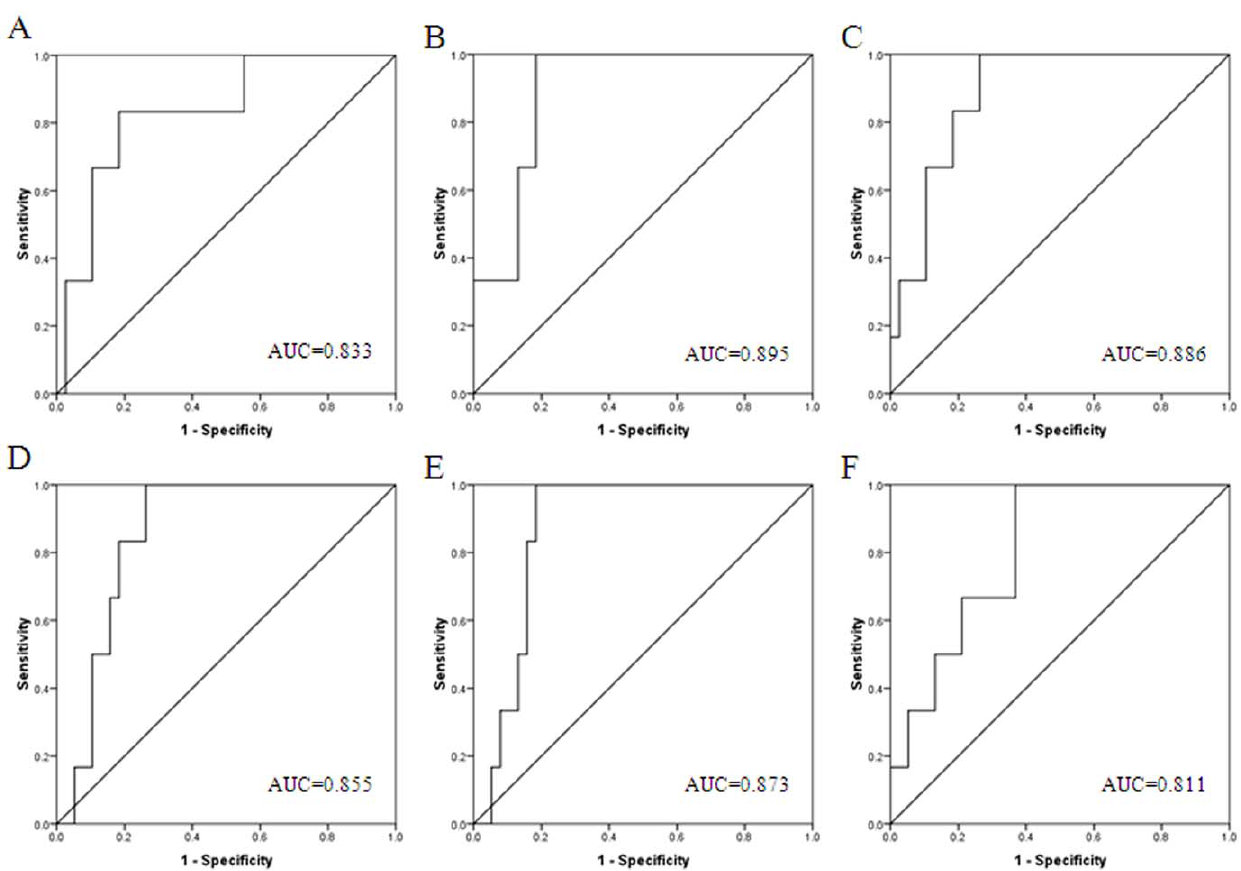
Figure 5. Receiver operating characteristic curve analysis was employed to determine whether the miRNAs found are really good candidates to discriminate early from advanced tumour stages. The sensitivity and specificity for each miRNA were plotted: (A) has-let-7c ( P =0.009); (B) has-miR-100 ( P =0.002); (C) has-miR-125b ( P =0.003); (D) has-miR-143 ( P =0.006); (E) has-miR-145 ( P =0.004); (F) has-miR-199a-5p ( P